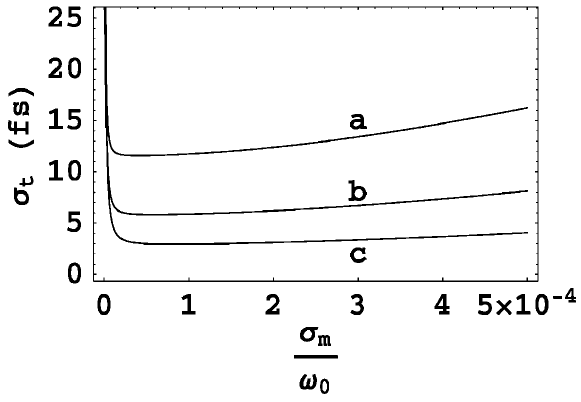
FIG. 1. For LCLS, we plot the rms pulse duration (cid:1) (cid:1) 1 : 2 (cid:4) 10 19 s (cid:5) 1 (cid:6) radiation after a monochromator 1 : 5 (cid:6)A (cid:3) ! 0 =! for a (full) energy chirp across the with rms bandpass (cid:1) m 0 230 fs electron bunch of ( a ) 0.5% as considered in Refs. [5,6]; ( b ) 1% as considered in the LCLS conceptual design report [1]; and ( c ) 2%. The SASE gain bandwidth is taken to be (cid:1) 5 (cid:4) 10 (cid:5) 4 , which is the value (equal to the Pierce parameter) expected near